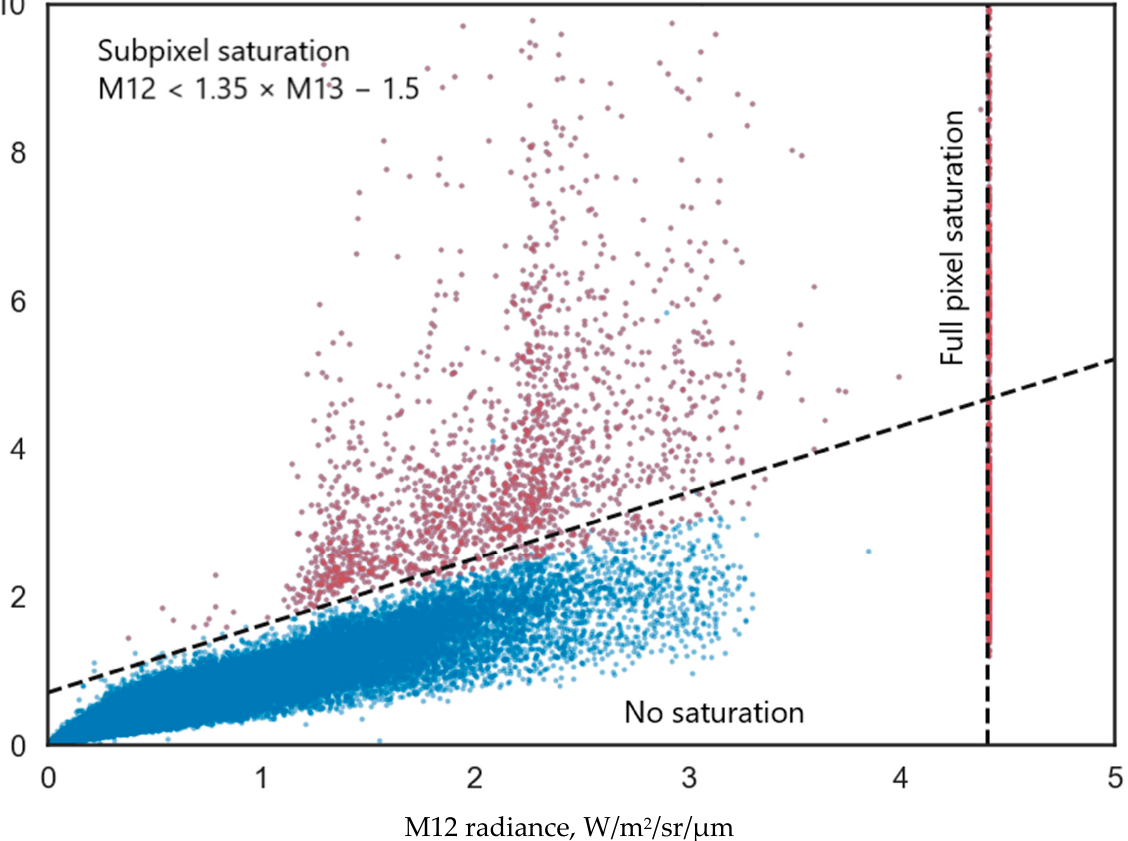
Figure 9. Scattergram of the VNF pixels with detection in M12–M13 spectral bands from entirety of 2018 with full and subpixel saturation regions.